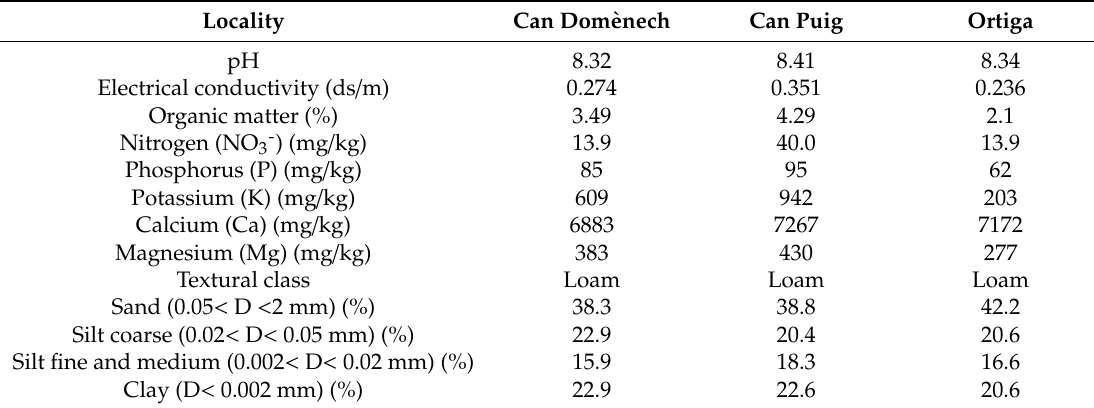
Table 1. Soil characteristics of the three experimental